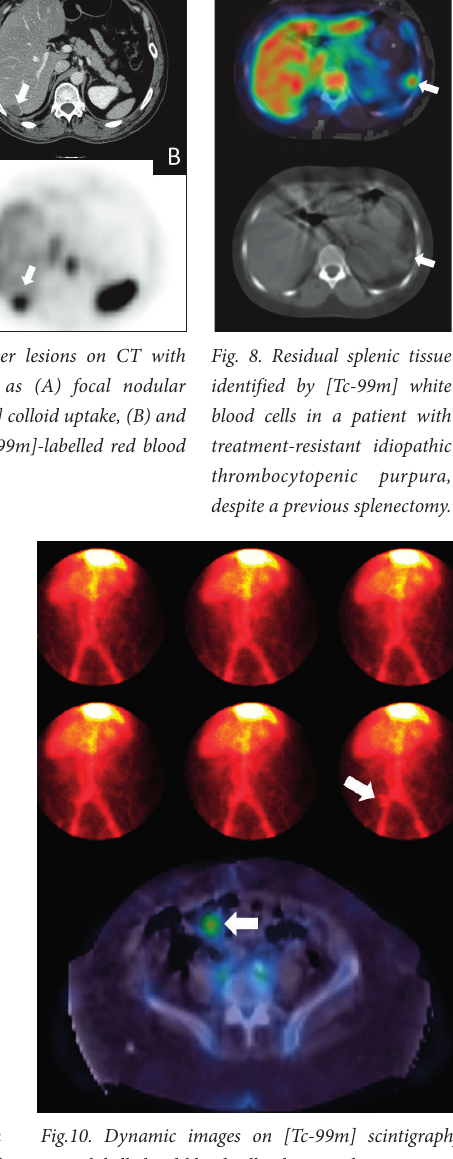
Fig.10. Dynamic images on [Tc-99m] scintigraphy using labelled red blood cells, showing the appearance of activity in the right iliac fossa, localised to the bowel in the ileo-caecal region on